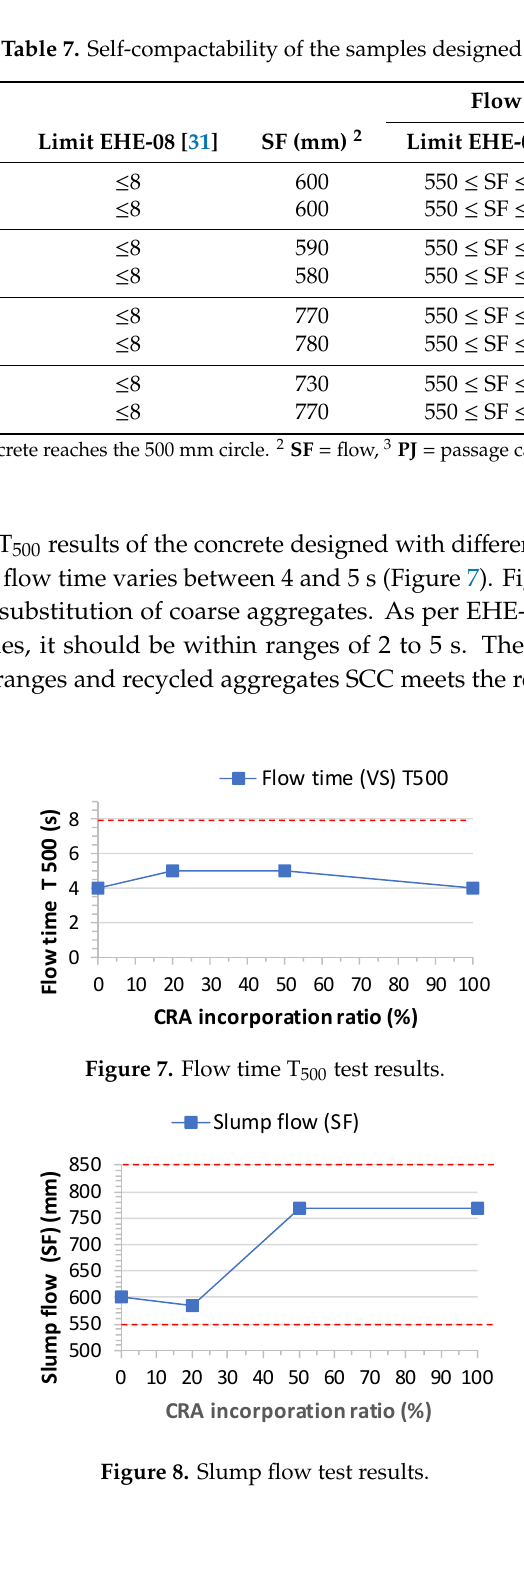
Figure 9. Passage capacity test results. In terms of slump flow, a higher ratio of CRA leads to a larger final diameter and smaller passage capacity. The effect of CRA on the T 500 slump flow time of the SCC should have been obvious for the 50% and 100% mixes, but they did not become more viscous with the increase in the percentage of superplasticizer. Visually, Mix 20 and Mix 50 reflected a good distribution of coarse aggregate and an absence of segregation and bleeding (Figure 6). Generally, slump flow decreases with the CRA incorporation ratio since more water is absorbed as the ratio increases. Some authors, such as Safiuddin et al. [22], Tuyan et al. [29] and Modani and Mohitkar [30], have found that the slump flow increases for relatively small CRA incorporation ratios (20–40%) and the slump flow decreases for higher ratios (70–100%) because the fine aggregates content tend to increase due to the fracture during mixing and the resulting higher water absorption. However, according to Pereira-de-Oliveira el al. [21], slump flow increases with CRA’s incorporation ratio given the gradual increase of SP content. This theory matches our results (Figures 10 and 11).